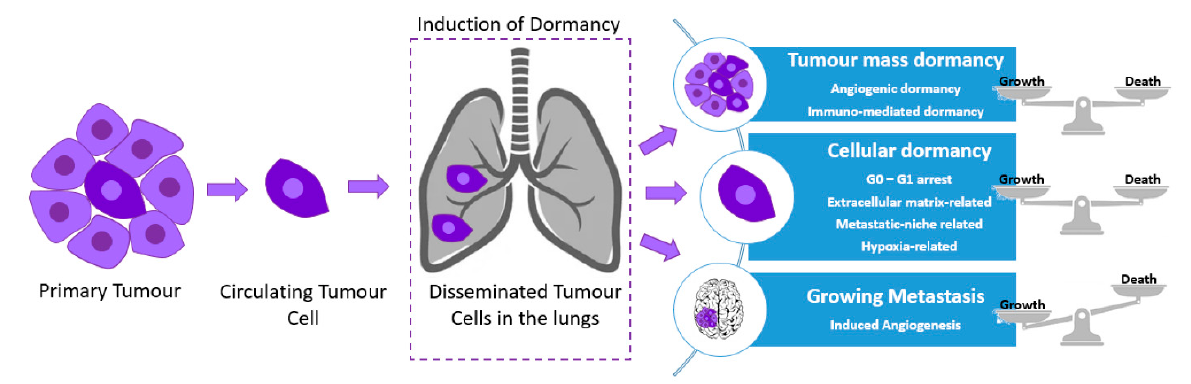
Figure 1. Cellular dormancy and tumor mass dormancy in the lungs. Tumor cells leave the primary tumor and enter the blood circulation (circulating tumor cells (CTCs)). These aggressive cancer cells occupy distant organ sites where they self-seed and become dormant (disseminated tumor cells (DTCs)). DTCs can develop a secondary tumor in a distant organ site immediately or at a later stage (a process known as metastasis), or they can maintain the dormant state for prolonged periods of time. Over the years, these dormant tumor cells can escape from the dormancy state and develop metastasis. When the balance between growth and death is achieved, the cells/tumor mass are/is in cell/tumor mass dormancy. In cellular dormancy, growth and death rates are limited.